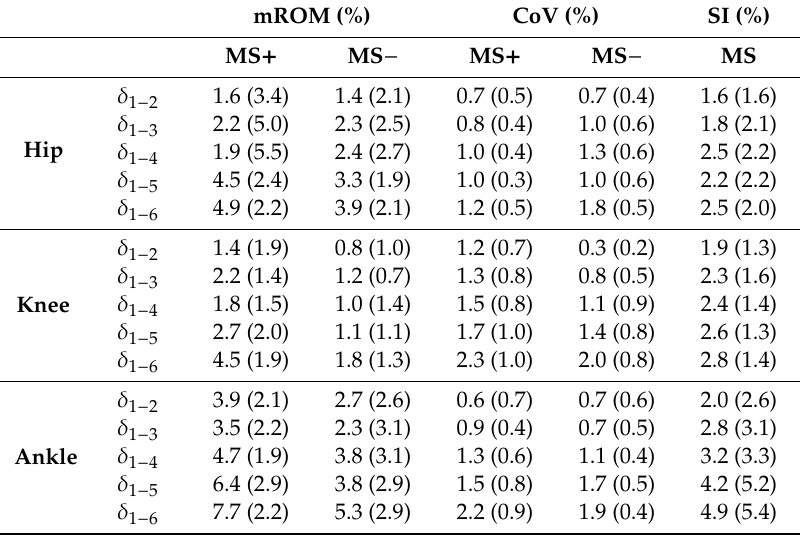
Table 7. Mean (standard deviation) related to the δ r for the ROM and δ CoV and SI index. MS + and MS − represent the most and the least variable side of patients, respectively.